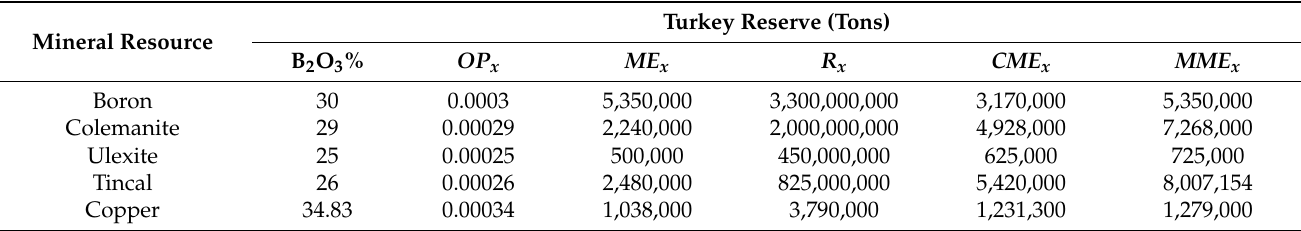
Table 5. Characterization factor that was obtained by ReCiPe method for Turkey (the year 2020) [32,33].